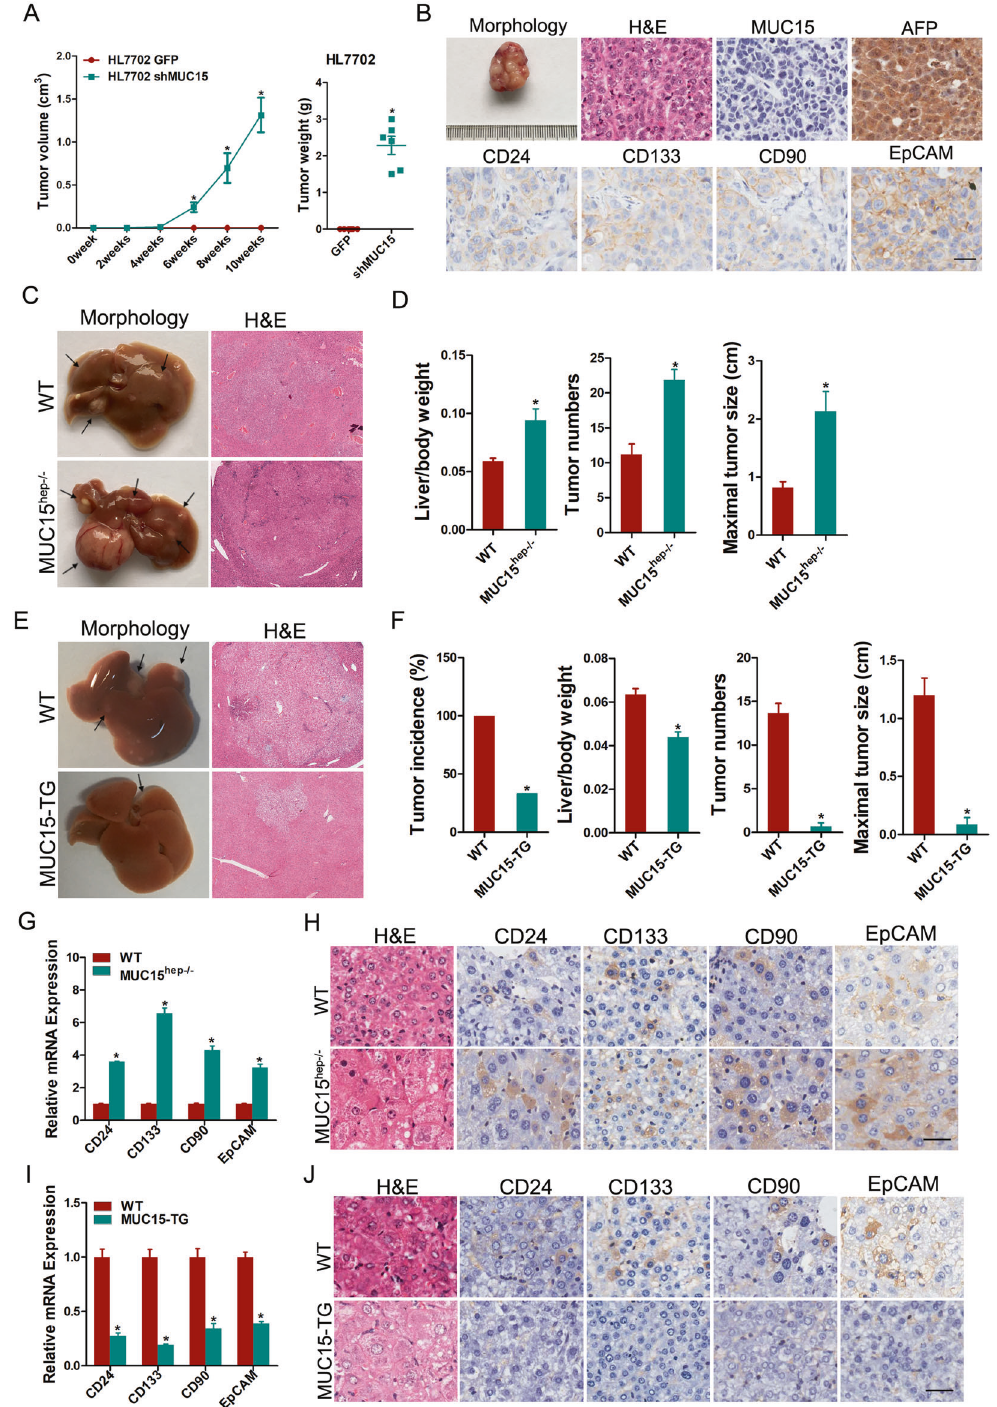
Fig. 1 MUC15 suppresses hepatocellular oncogenesis via inhibiting T-ICs generation. A HL7702 shMUC15 and control cells were injected subcutaneously into NOD-SCID mice at 1 × 10 3 cells per mouse. Xenografted tumor growth was monitored, and tumor weight was measured 10 weeks later. B The tumor formed in E was subjected to H&E and IHC staining. Scale bar = 25 μ m. C Representative images and H&E staining of MUC15 hep − / − and WT mice at 5 months after DEN injection ( n = 6). D The tumor numbers, maximal tumor sizes and liver-to-body weight ratios of MUC15 hep − / − and WT mice at 5 months after DEN injection was measured. E Representative images and H&E staining of MUC15-TG and WT mice at 5 months after DEN injection ( n = 6). F The tumor incidence, tumor numbers, maximal tumor sizes, and liver-to-body weight ratios of MUC15-TG and WT mice at 5 months after DEN injection was measured. G , H The mRNA and protein expression of TIC-associated markers in tumors from MUC15 hep − / − and WT mice at 5 months after DEN injection were examined by real-time PCR and IHC staining analysis. Scale bar = 25 μ m. I , J The mRNA and protein expression of TIC-associated markers in tumors from MUC15-TG and WT mice at 5 months after DEN injection were examined by real-time PCR and IHC staining analysis. Scale bar = 25 μ m. All results are presented as the mean ± SD, and statistical signi fi cance was assessed using a two-tailed Student t -test. * p <